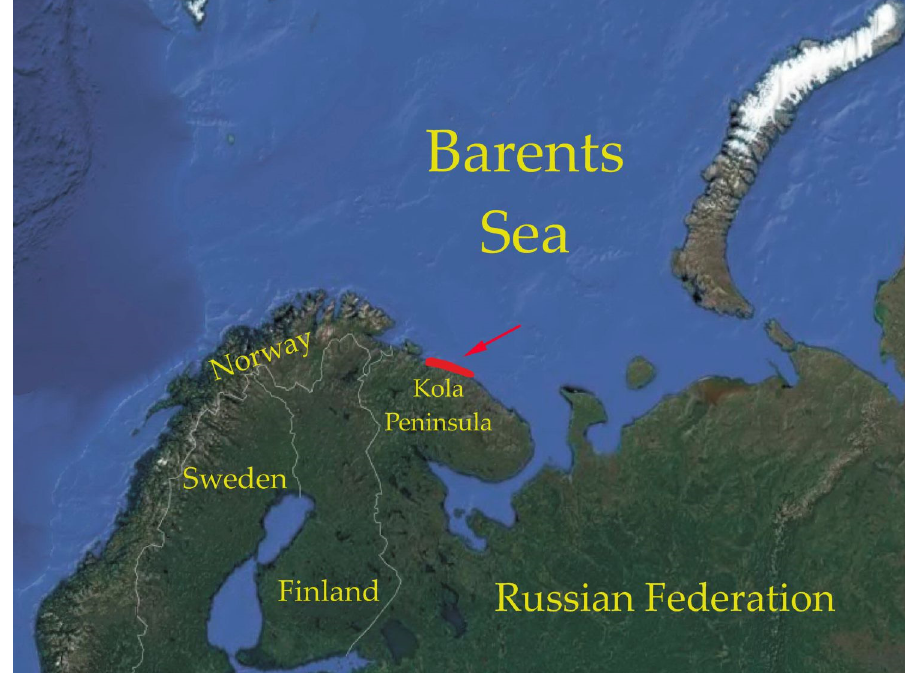
Figure 1. Map of the study area.